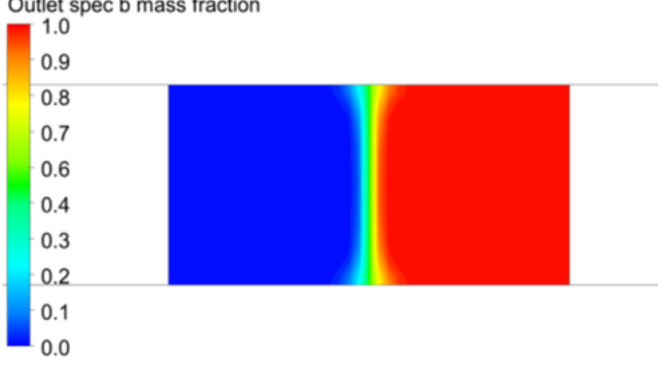
Figure 7. Mass fraction contour at outlet of T-mixer at Re = 160